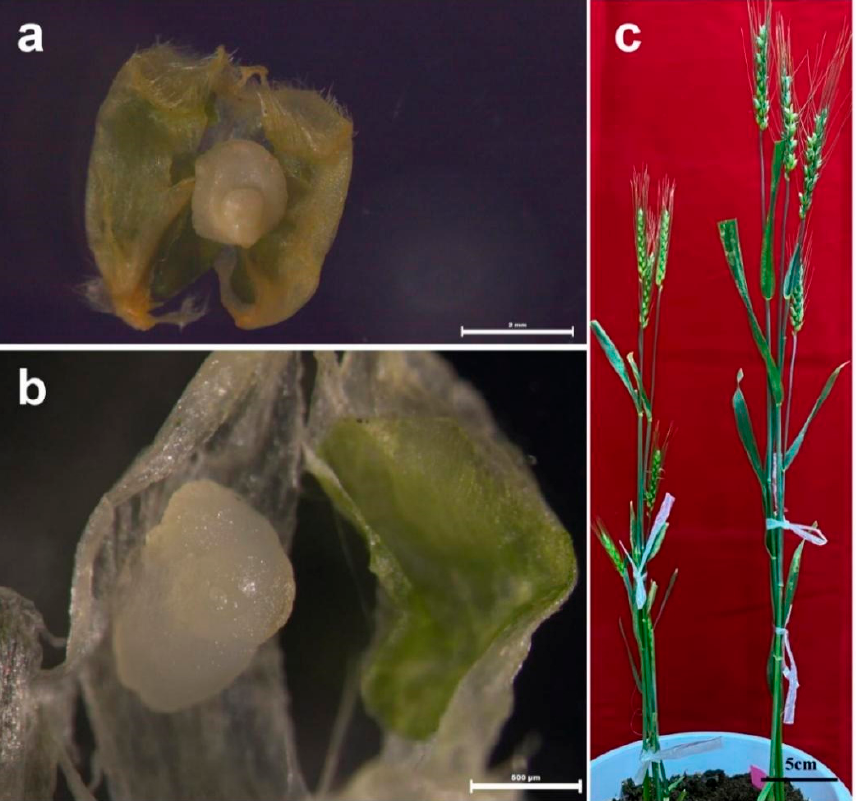
Figure 3. Immature endospermless wheat grains and in vitro rescued embryos of the mtl mutants. ( a ) An endospermless grain with normal embryo, scale bar = 2 mm; ( b ) An endospermless grain with defective embryo, scale bar = 500 µ m; ( c ) Haploid plant (left) and diploid plant (right) derived from endospermless grains, scale bar = 5